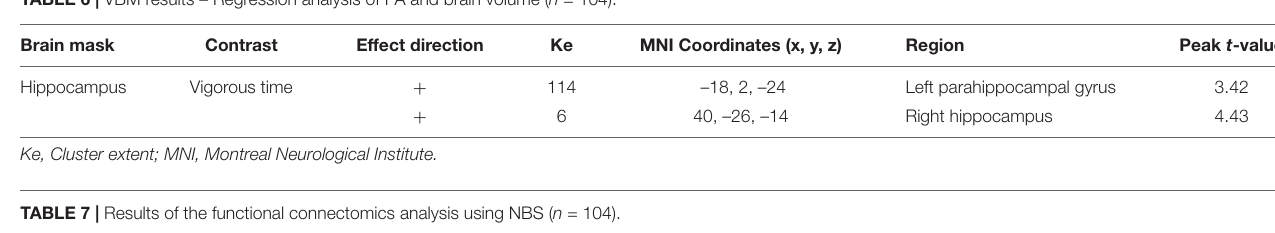
FIGURE 3 | Sagittal, coronal, and axial view of the clusters and the scatter plot showing a significant positive correlation between vigorous time and: (A) left parahippocampal gyrus (–18, 2, –24) and (B) right hippocampus (40, –26, –14), after controlling for age, gender, age, MMSE, and GDS. All clusters illustrated were defined with a threshold at a p -value of 0.1. TABLE 6 | VBM results – Regression analysis of PA and brain volume ( n = 104).